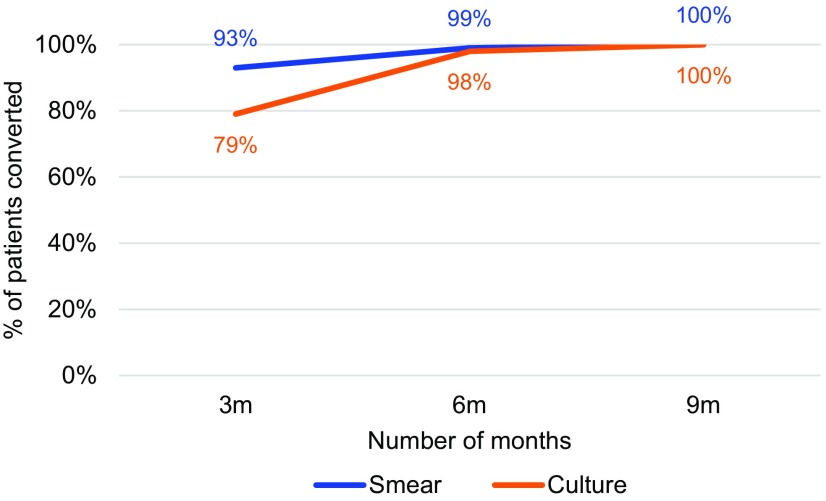
Sputum and Culture Conversion Rates of DR-TB Patients After Treatment Initiation, BangladeshAbbreviation: DR-TB, drug-resistant tuberculosis.